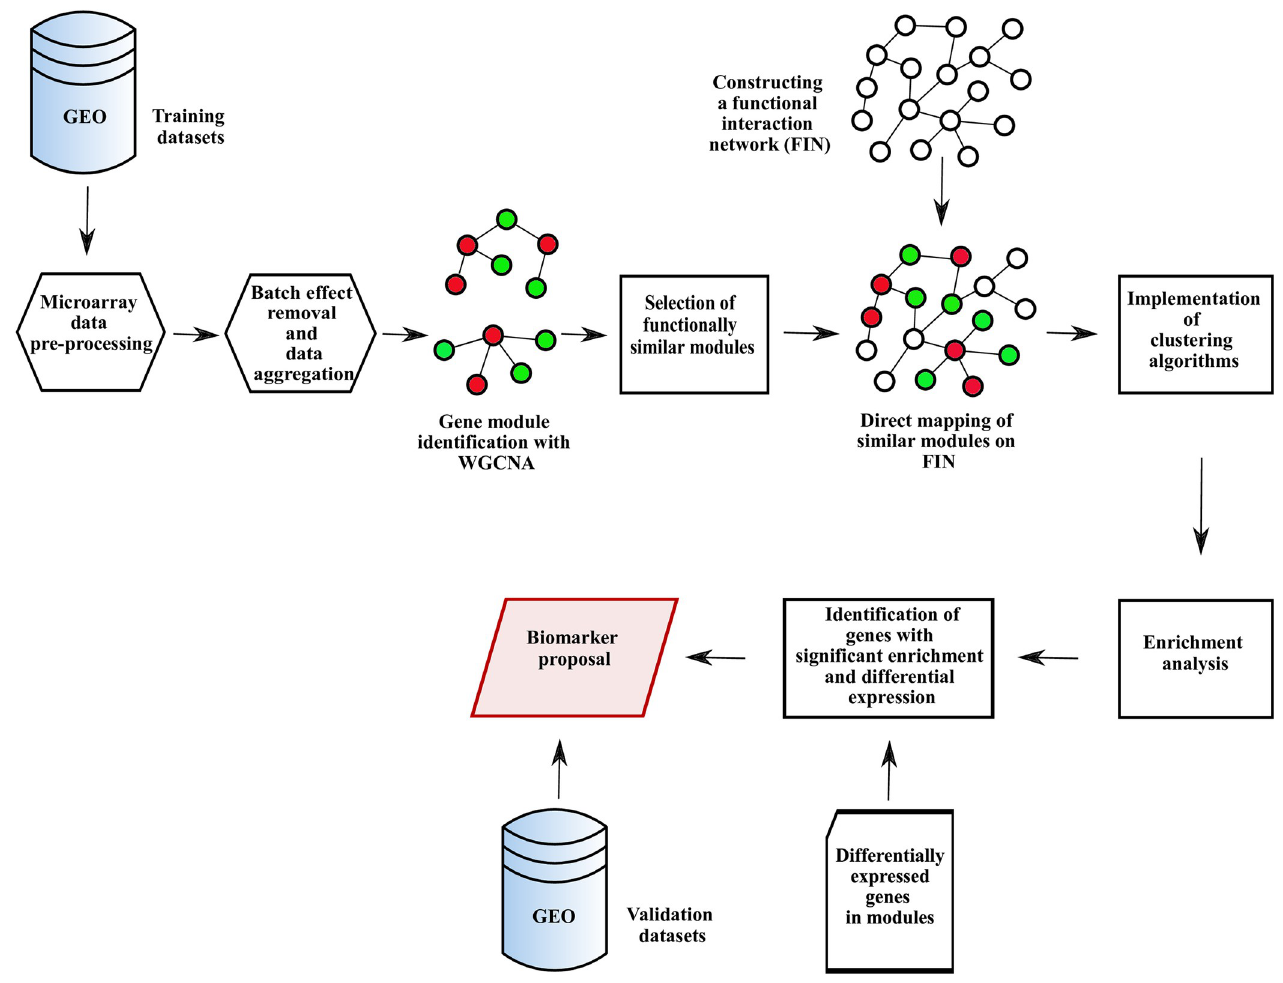
Fig 1. An overview of the